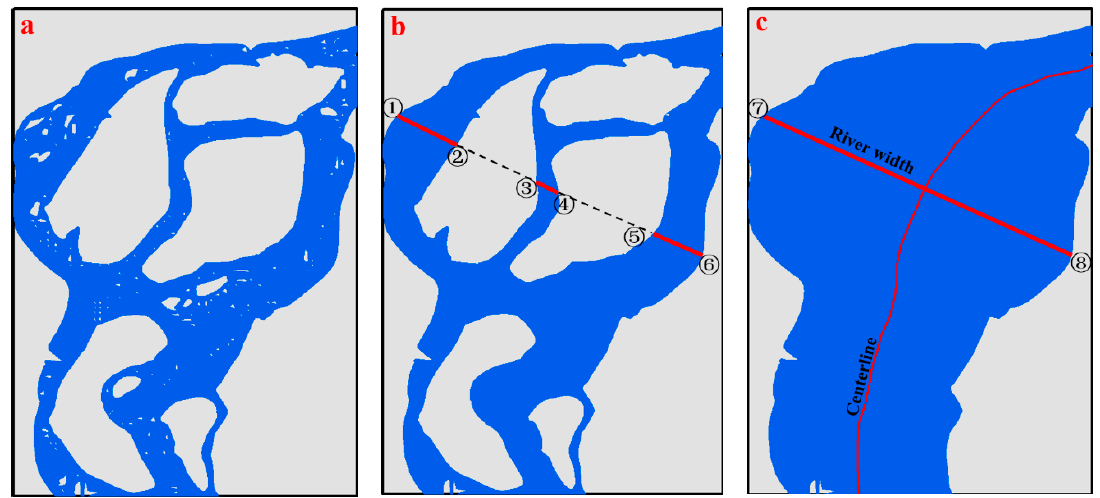
Figure 6. Gap-fill processing results. ( a ) River extraction from Sentinel-2 images. ( b ) Filling small gaps. ( c ) Filling all gaps, where red line represents river width.